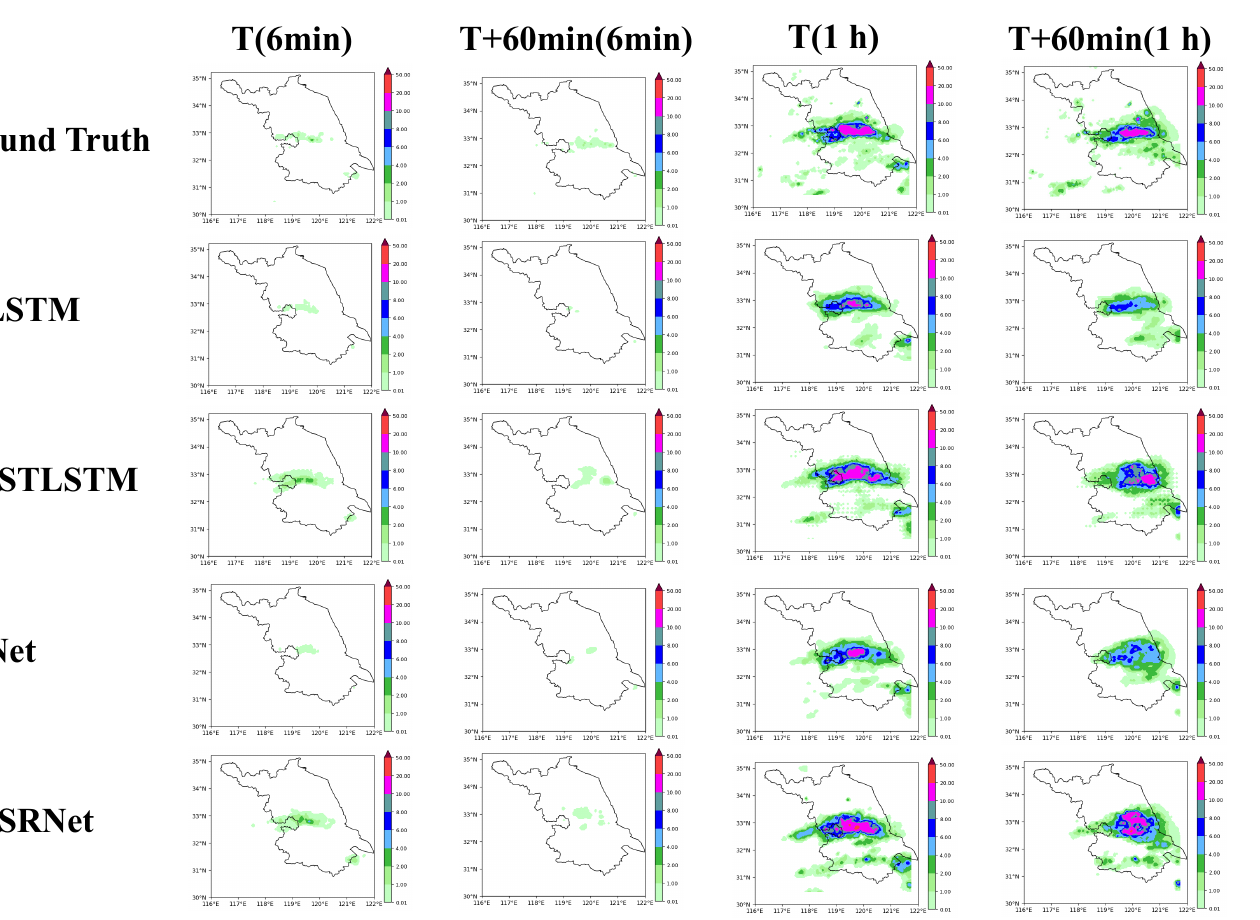
Figure 10. Visual comparison with ablation results. The first column of each row is the 6-min cumulative precipitation from time T to time T + 6 min, the second column is the 6-min cumulative precipitation from time T + 60 min to time T + 66 min, the third column is the 1-h cumulative precipitation from time T to time T + 60 min, and the fourth column is the 1-h cumulative precipitation from time T + 60 min to time T + 120